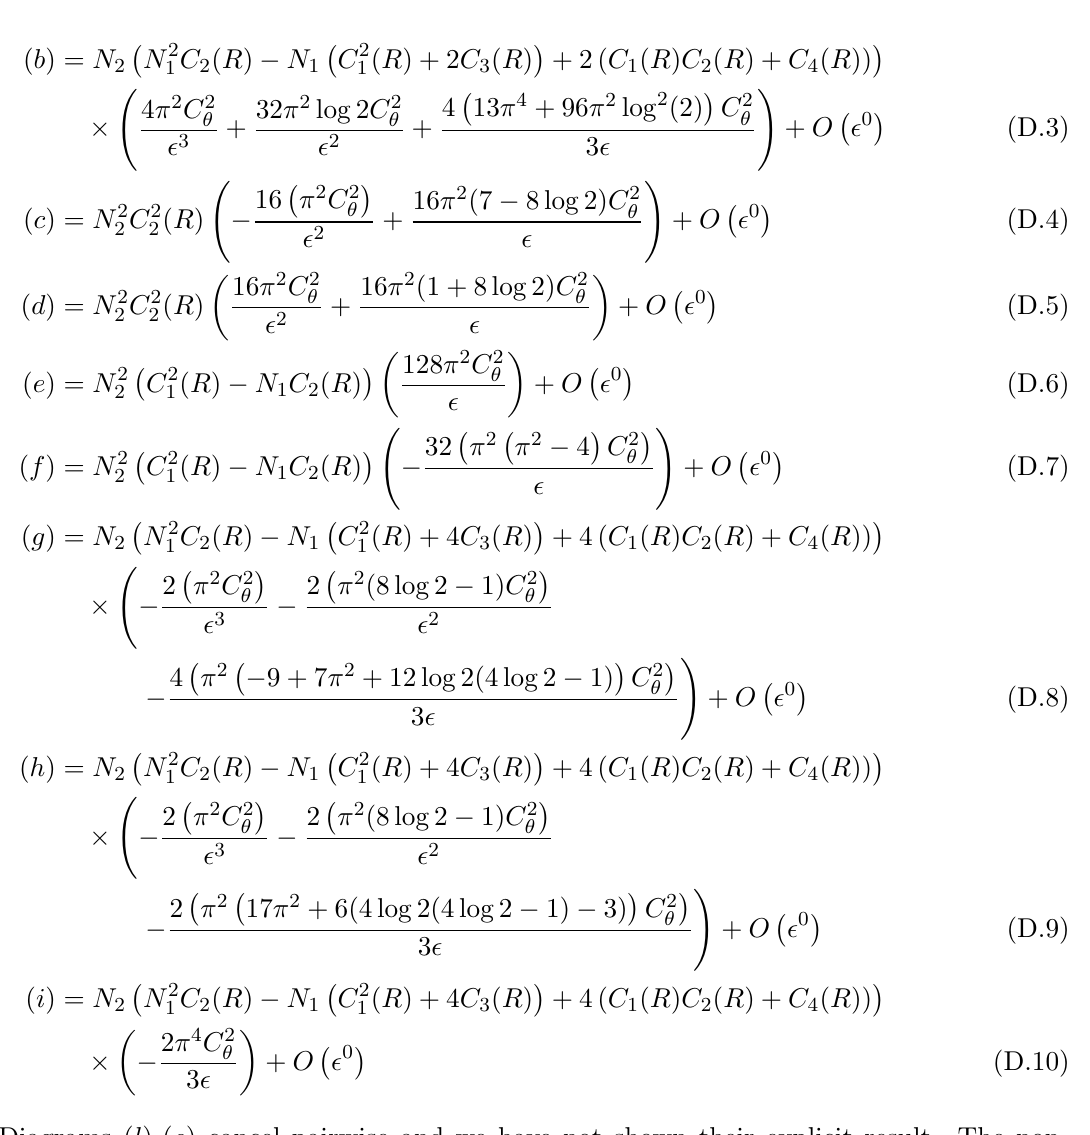
Figure 4. List of non-planar diagrams contributing to the four-loop (cid:18) -Bremsstrahlung